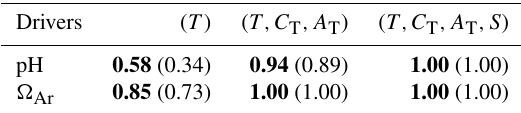
Table 3. Spatial correlation ( r ) and explained variance ( r 2 ; in parenthesis) between pH and pH( T ), pH( T,C T ,A T ), and pH( T,C T ,A T ,S ) and between (cid:127) Ar and (cid:127) Ar ( C T ,A T ), (cid:127) Ar ( C T ,A T ,T ), and (cid:127) Ar ( C T ,A T ,T,S ) in the Nordic Seas’ surface (0m) waters. Numbers in bold indicate the significant